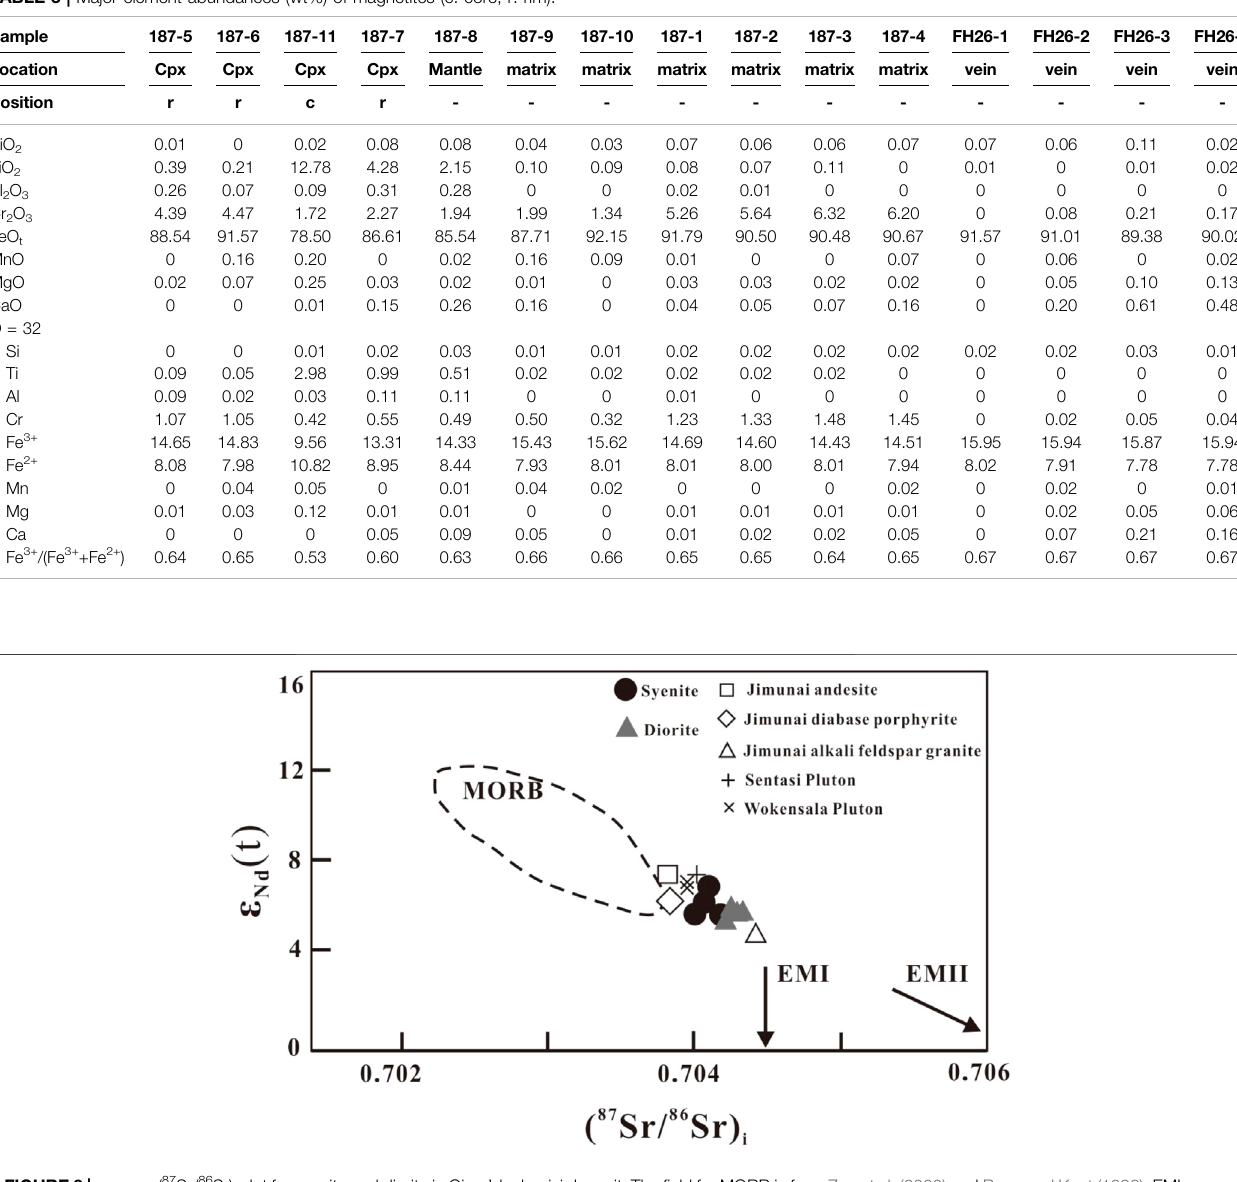
FIGURE 8 | ε Nd(t) vs. ( 87 Sr/ 86 Sr) i plot for syenite and diorite in Qiaer ’ dunbasixi deposit. The fi eld for MORB is from Zou et al. (2000) and Barry and Kent (1998), EMI andEMIIarefromZindlerandHart(1986).Jimunaiandesite,silliteandalkali – feldspargranitearefromHeetal.(1994),SentasiandWokensalaintrusionsarefromYuanet al.